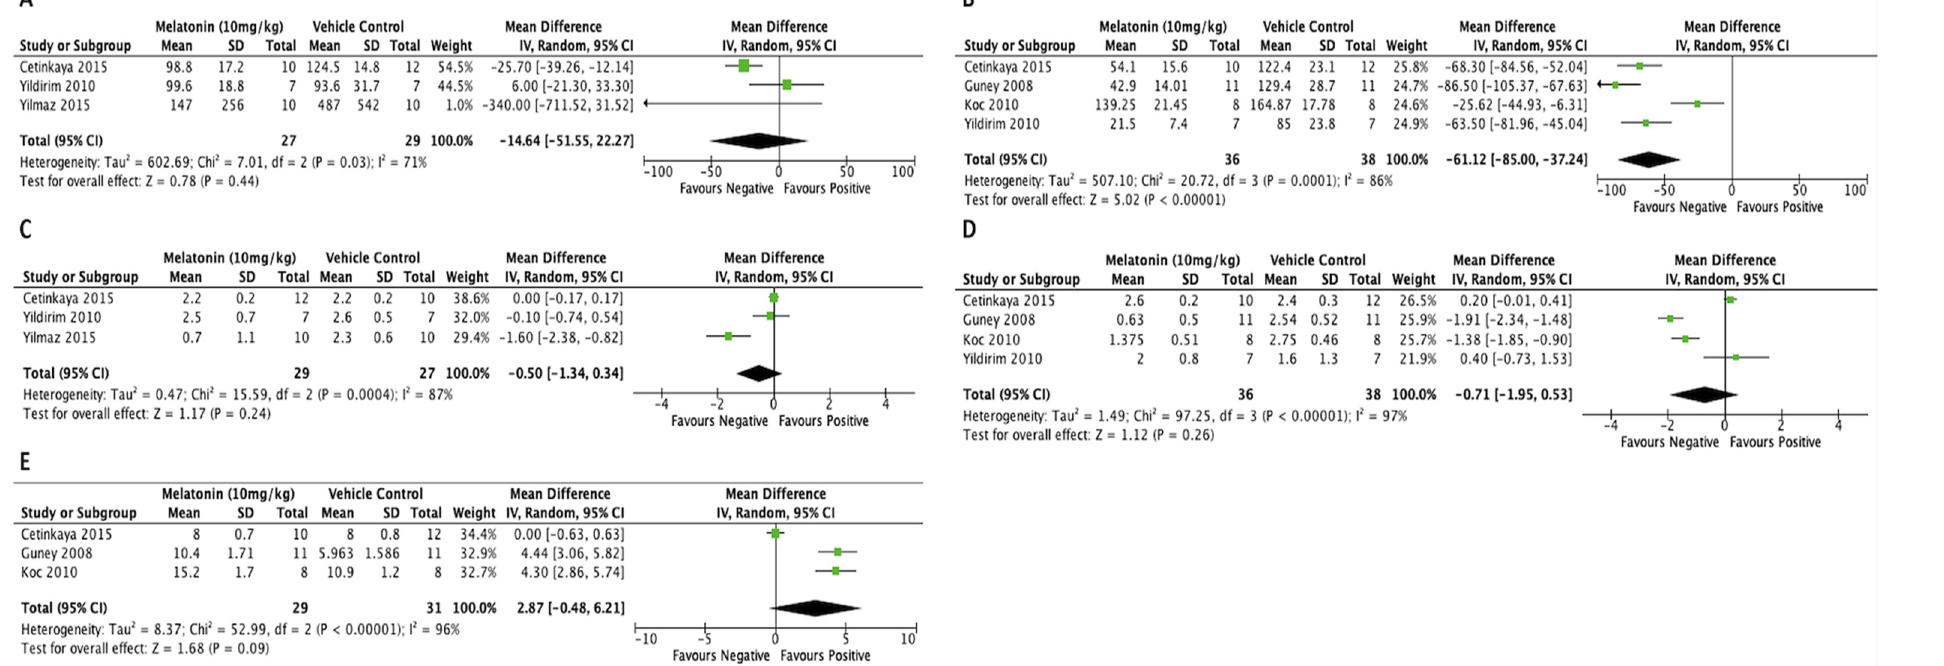
Figure 2. Forest plots of effectiveness of melatonin treatment compared with control in endometriosis. Forest plot of included studies comparing the effect of exogenous melatonin (10 mg/kg) in a rat model of endometriosis. ( A ) Lesion size at 2 weeks [50,51,61]. ( B ) Lesion size at 4 weeks [50,58,61,62]. ( C ) Histopathological score after 2 weeks [50,51,61]. ( D ) Histopathological score after 4 weeks [50,58,61,62]. ( E ) Level of superoxide dismutase (SOD) after 2 weeks